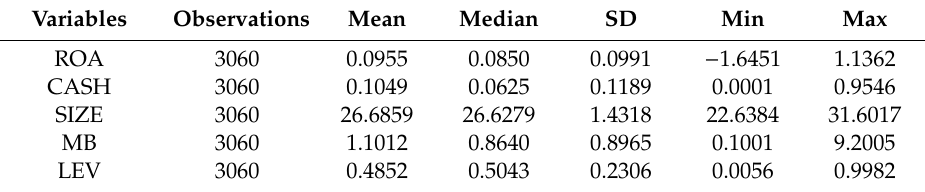
Table 1. Descriptive statistic of variables.